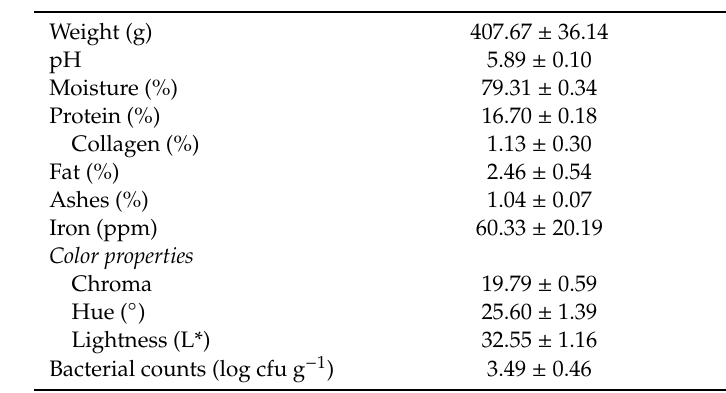
Table 2. Physicochemical characteristics and microbiological quality of raw porcine hearts (means ± SD, n =